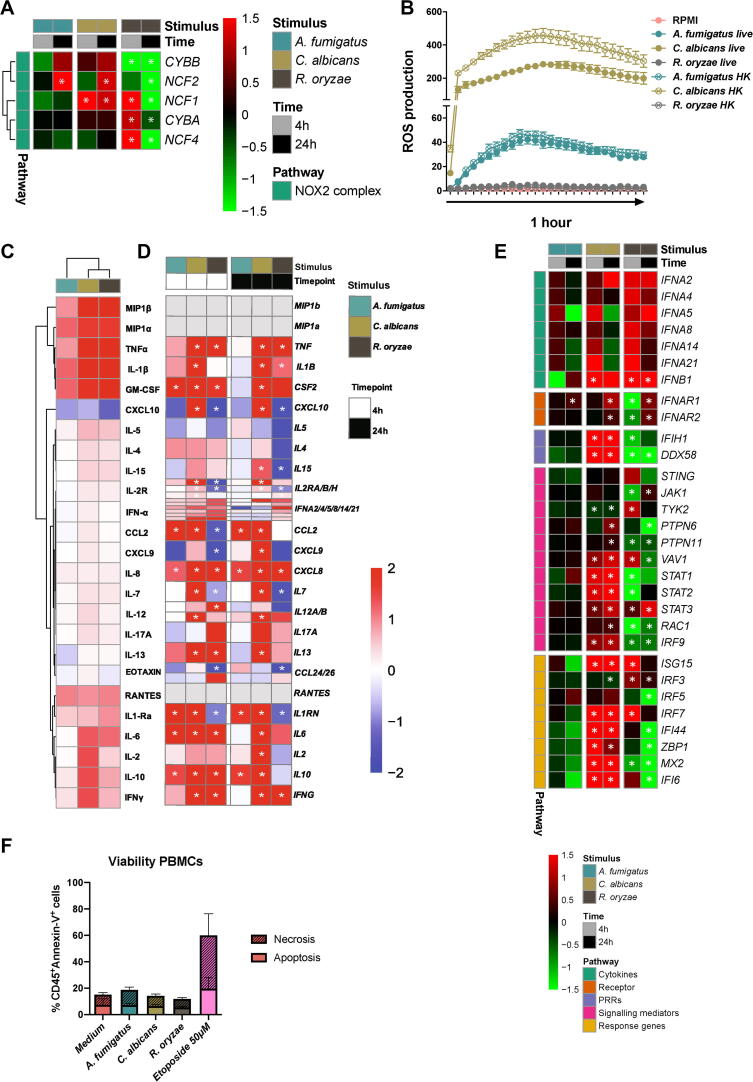
Comparative host response profile of human PBMCs (A) Heatmap of transcriptional expression of NADPH-oxidase 2 subunits extracted from the RNA-Seq dataset of PBMCs stimulated with A. fumigatus, C. albicans and R. oryzae for 4 h and 24 h compared to unstimulated cells (RPMI). The color indicates the Log2FC (Shades of red indicate upregulation, while shades of green downregulation, see legend; the white asterisk indicates genes with an adjusted p-value < 0.05). (B) Time-course during one hour of PBMCs from healthy volunteers stimulated with live and heat-killed forms of A. fumigatus, C. albicans and R. oryzae. Measurements (ROS induction, RLU/sec) were taken within 1 h in intervals of 2.23 min (n = 6 donors). (C) Heatmaps of cytokine production measured in culture supernatants of PBMCs from healthy volunteers (n = 9 donors) stimulated with the fungal stimuli used for the transcriptomics (A. fumigatus, C. albicans and R. oryzae) compared to the unstimulated cells. Means of the Log10 fold-changes were calculated, and the data were clustered using hierarchical clustering on both axes (Euclidean distance, average linkage). (D) Heatmap of the expression of corresponding cytokine genes to the cytokines measured in (C) extracted from the RNA-Seq dataset of PBMCs stimulated A. fumigatus, C. albicans and R. oryzae for 4 h and 24 h. The Log2FC compared to unstimulated cells is shown, with * indicating a corrected p-value of < 0.05 (E) Heatmap of transcriptional expression of interferon-related genes extracted from the RNA-Seq dataset of PBMCs stimulated with A. fumigatus, C. albicans, and R. oryzae for 4 h and 24 h compared to unstimulated cells (RPMI); the color indicates the Log2FC (Shades of red indicate upregulation, while shades of green downregulation, see legend; the white * indicates adjusted p-value < 0.05). (F) Viability of PBMCs (n = 4) assessed by Annexin-V and PI staining after 24 h stimulation with A. fumigatus, C. albicans, and R. oryzae, as well as positive controls for apoptosis (Etoposide, 50 μM) and necrosis (Heat-killing of cells for 1 min at 65 °C) or negative control unstimulated cells in RPMI medium. The percentage apoptotic cells gated on the singlet, CD45+ cells are visualized by Annexin-V positive staining, while the percentage of necrotic cells gated on the singlet, CD45+ cells are visualized by Annexin-V and PI positive staining. (For interpretation of the references to color in this figure legend, the reader is referred to the web version of this article.)